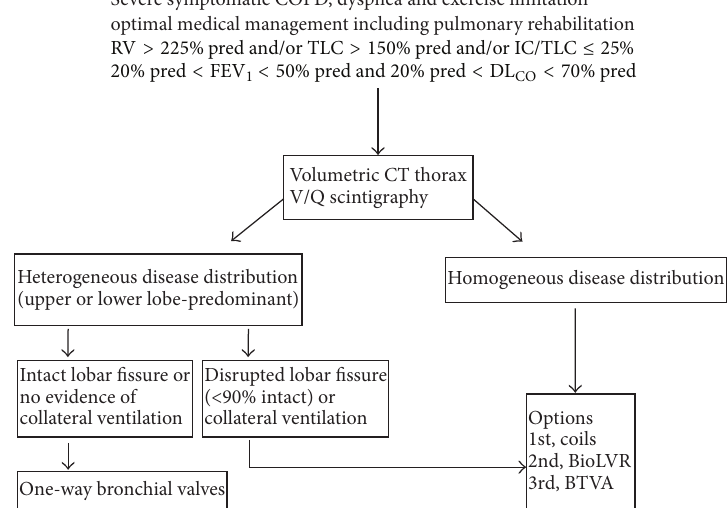
Figure 1: Algorithm for endoscopic LVR evaluation and selection of procedure. BioLVR: biological lung volume reduction; BTVA: bronchial thermal vapour ablation; CT: computed tomography; IC: inspiratory capacity; pred: predicted; RV: residual volume; TLC: total lung capacity; V/Q: